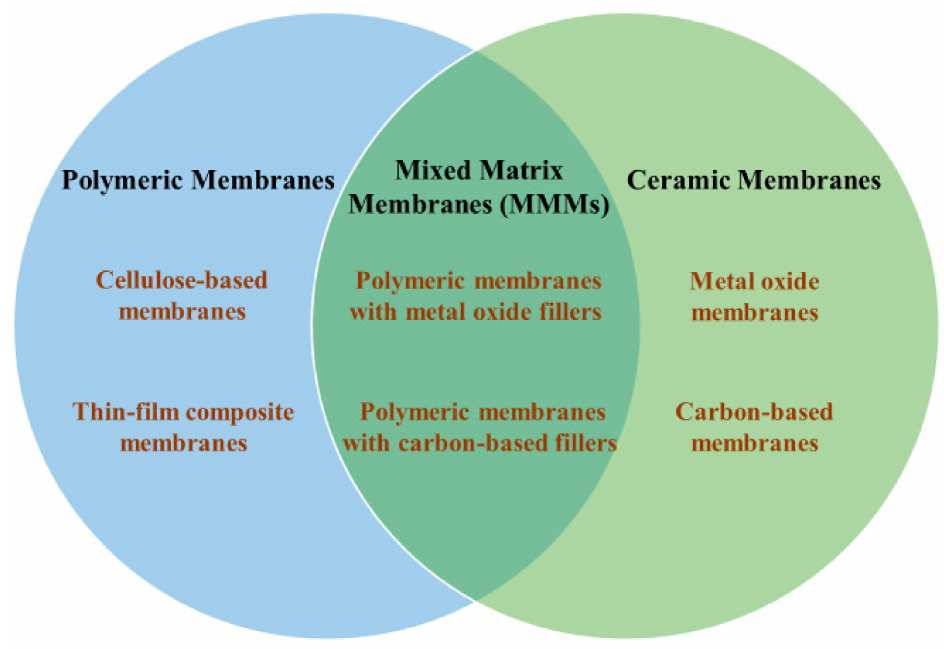
Figure 2. Representative reverse osmosis (RO) and nanofiltration (NF) membranes for water